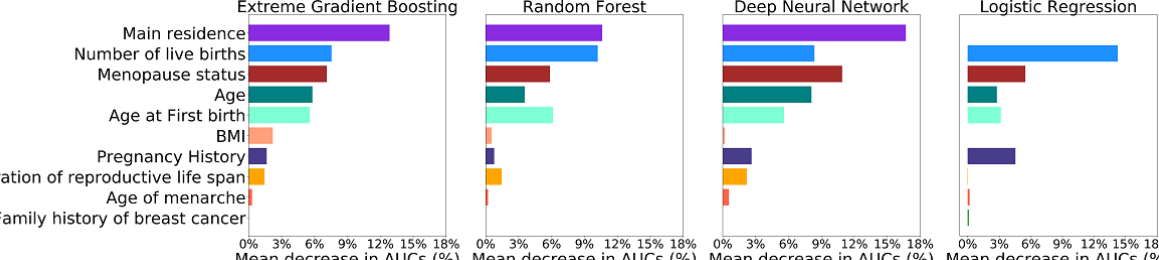
Figure 3. Variable rankings according to the mean area under the receiver operating characteristic curve decrease in percentage in the four machine learning